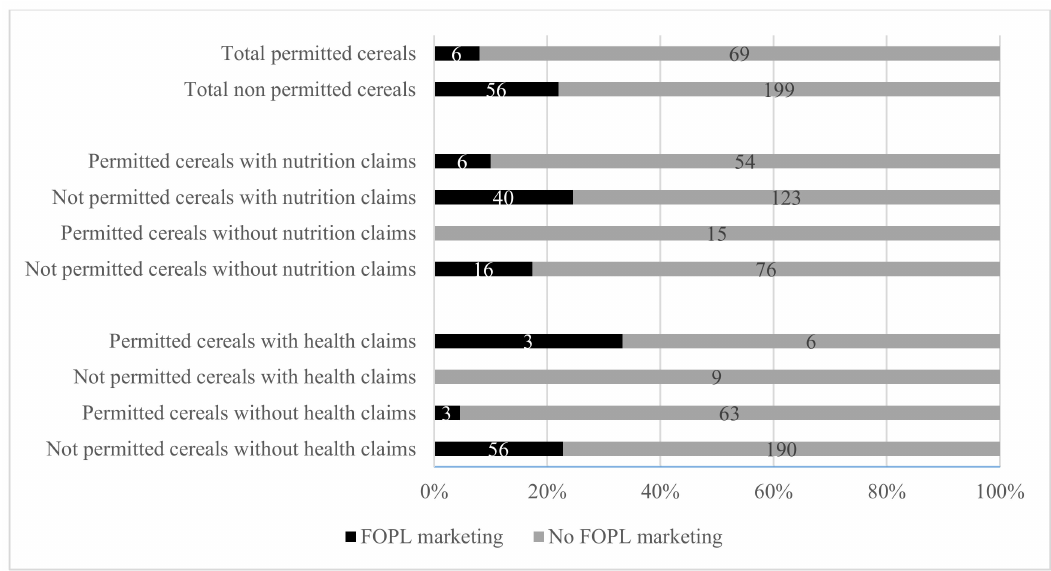
Figure 2. Proportion of breakfast cereals on the Belgian market in 2018 permitted or not permitted to be marketed by the WHO Europe nutrient profile classification with and without promotional characters ( = FOPL marketing) on the